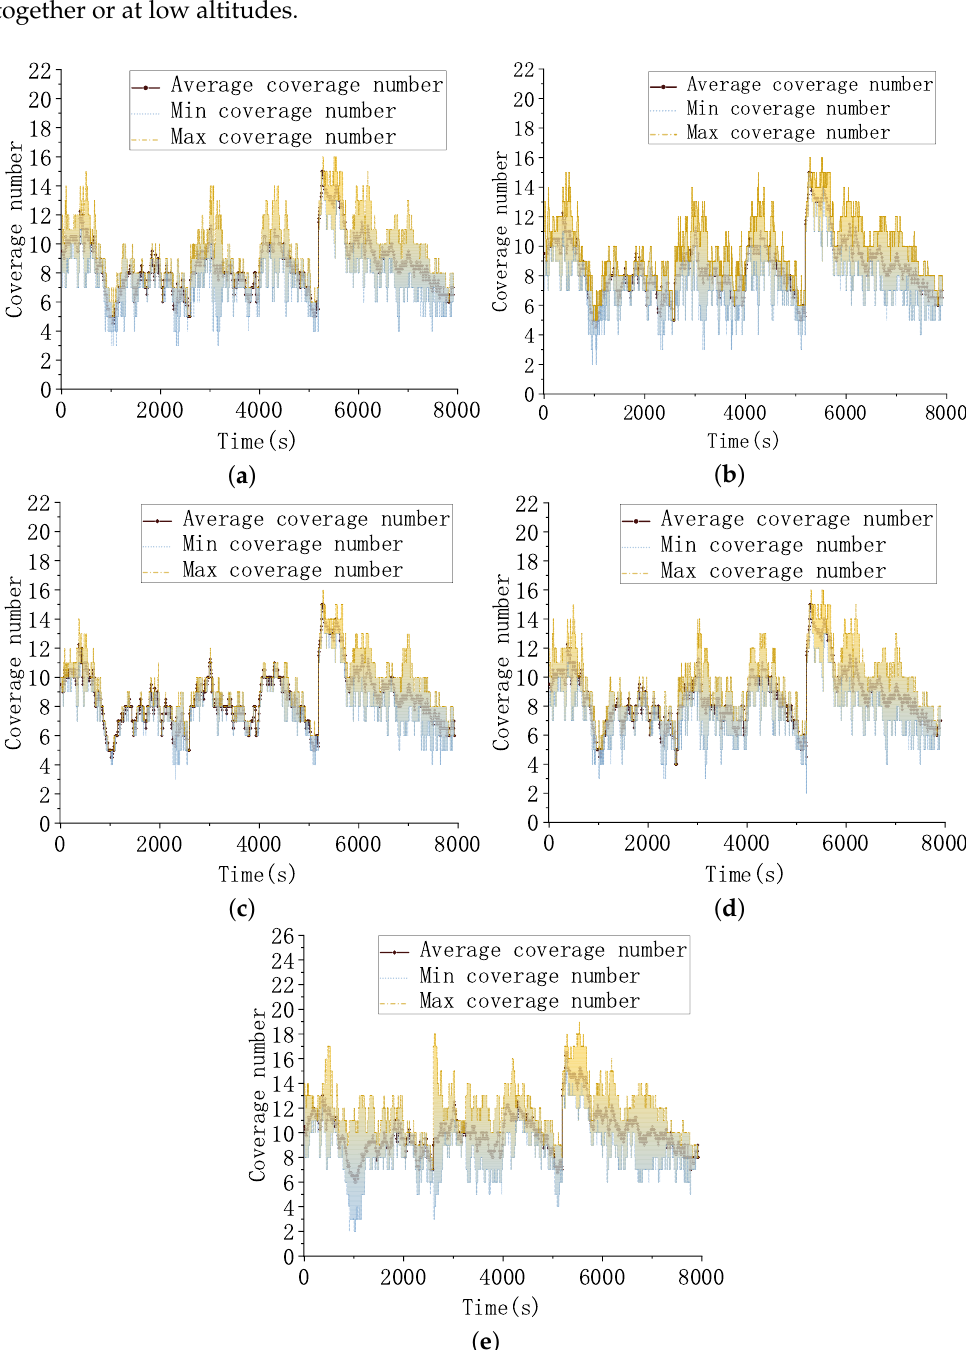
Figure 14. Target covered folds. ( a ) Coverage folds of the MADDPG algorithm for the targets. ( b ) Coverage folds of the MAPPO algorithm for the targets. ( c ) Coverage folds of the MAPPO-RHC algorithm for the targets. ( d ) Coverage folds of the HT3O algorithm for the targets. ( e ) Coverage folds of the HGPT algorithm for the